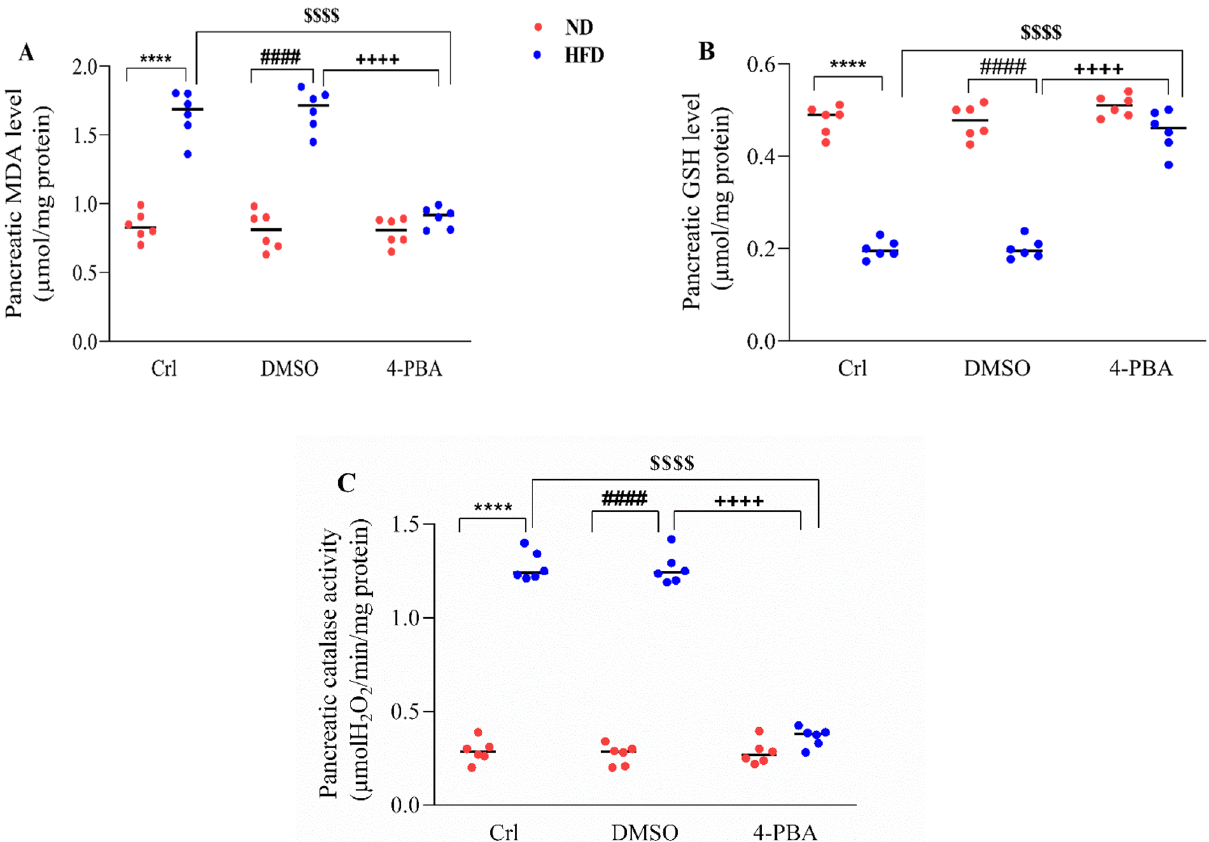
Figure 1. Effect of high-fat diet and/or 4-PBA on pancreatic ( A ) MDA and ( B ) GSH levels and ( C ) total catalase activity. Each point represents the mean ± SEM (6 rats/group). ****p < 0.0001 versus control of ND group, #### p < 0.0001 versus ND + DMSO group, $$$$ p < 0.0001 versus control of HFD group, ++++ p < 0.0001 versus HFD + DMSO group. ND Normal diet, HFD High-fat diet, Crl Control, DMSO Dimethyl Sulfoxide, 4-PBA 4-Phenyl Butyric group increased the WFS1 protein expression in the pancreas compared to HFD and HFD + DMSO groups (P < 0.0001); however, its value was significantly lower than that in the ND groups (P < 0.05) (Fig. 3A,D). Com- pared to the control group, DMSO injection had no effect on the level of this protein in any of the diet groups (Fig. 3A,D). The effect of high‑fat diet and/or 4‑PBA on the protein levels of CHOP, BIP and WFS1 in the extracted ER of pancreas. According to the statistical analysis, consumption of HFD substantially increased the protein levels of CHOP (Fig. 4A,B) and BIP (Fig. 4A,C) in the extracted ER of the pancreas in HFD and HFD + DMSO groups, compared to ND and ND + DMSO groups (P < 0.0001). In comparison to HFD and HFD + DMSO groups, 4-PBA injection reduced the protein levels of CHOP (P < 0.01) and BIP (P < 0.001) in the pancreatic extracted ER; however, these values were significantly higher than in the ND groups (P < 0.01) (Fig. 4A–C). In comparison to the control group, DMSO injection had no effect on the levels of these proteins in any of the diet groups (Fig. 4A–C). Compared to ND and ND + DMSO groups, there was a substantial increase in the WFS1 protein level in the pancreatic extracted ER of HFD and HFD + DMSO groups (P < 0.0001) (Fig. 4D,E). Administration of 4-PBA in the HFD + 4-PBA group decreased the WFS1 protein level in the extracted ER compared to HFD and HFD + DMSO groups (P < 0.0001) (Fig. 4D,E); however, its value was significantly higher than that of the ND groups (P < 0.01) (Fig. 4D,E). In comparison to the control group, DMSO injection had no effect on the level of this protein in any of the diet groups (Fig. 4D,E). The effect of high fat diet and/or 4‑PBA on the pancreatic isolated islets’ insulin secretion and insulin content in response to glucose. Consumption of HFD significantly decreased the pancreatic iso- lated islets’ insulin secretion in response to 5.6 and 16.7 mM glucose concentrations in HFD and HFD + DMSO groups, compared to ND and ND + DMSO groups (P < 0.0001) (Fig. 5A,B). In the presence of both glucose concentrations, the 4-PBA injection caused a significant increase of insulin secretion in the HFD + 4-PBA group, compared to HFD and HFD + DMSO groups (P < 0.0001), so that its value did not show any significant differ-